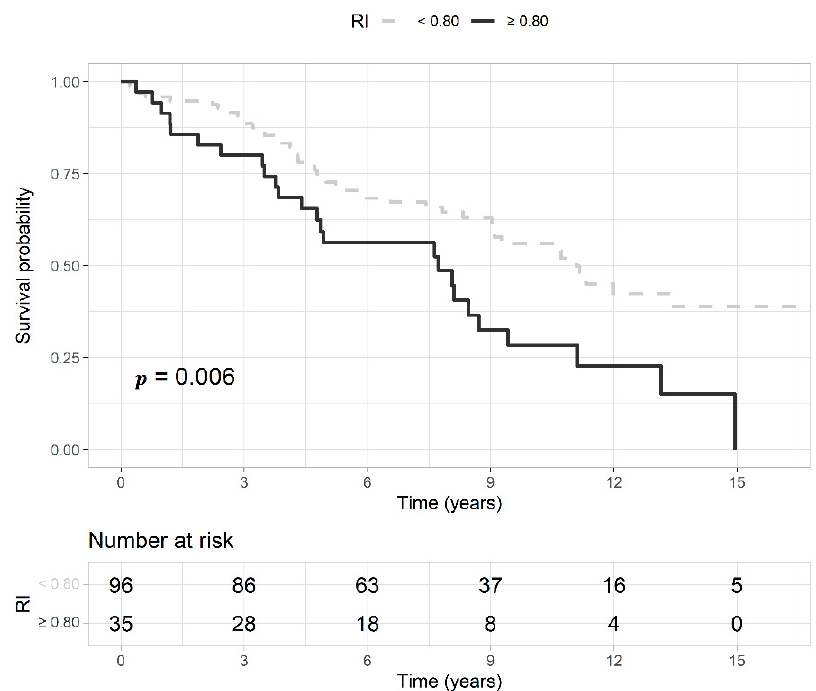
Figure 4. Kaplan-Meier curves represent the survival probability of patients with an intrarenal resistive index (RI) ≥ 0.80 (gray and dashed line) or <0.80 (black and continuous line) with the probability ( p ) of the log-rank test. Below the curves, is reported the risk table with the number of patients at risk at each time point. Table 5. Univariate and best Cox proportional hazards regression model for all-cause mortality.